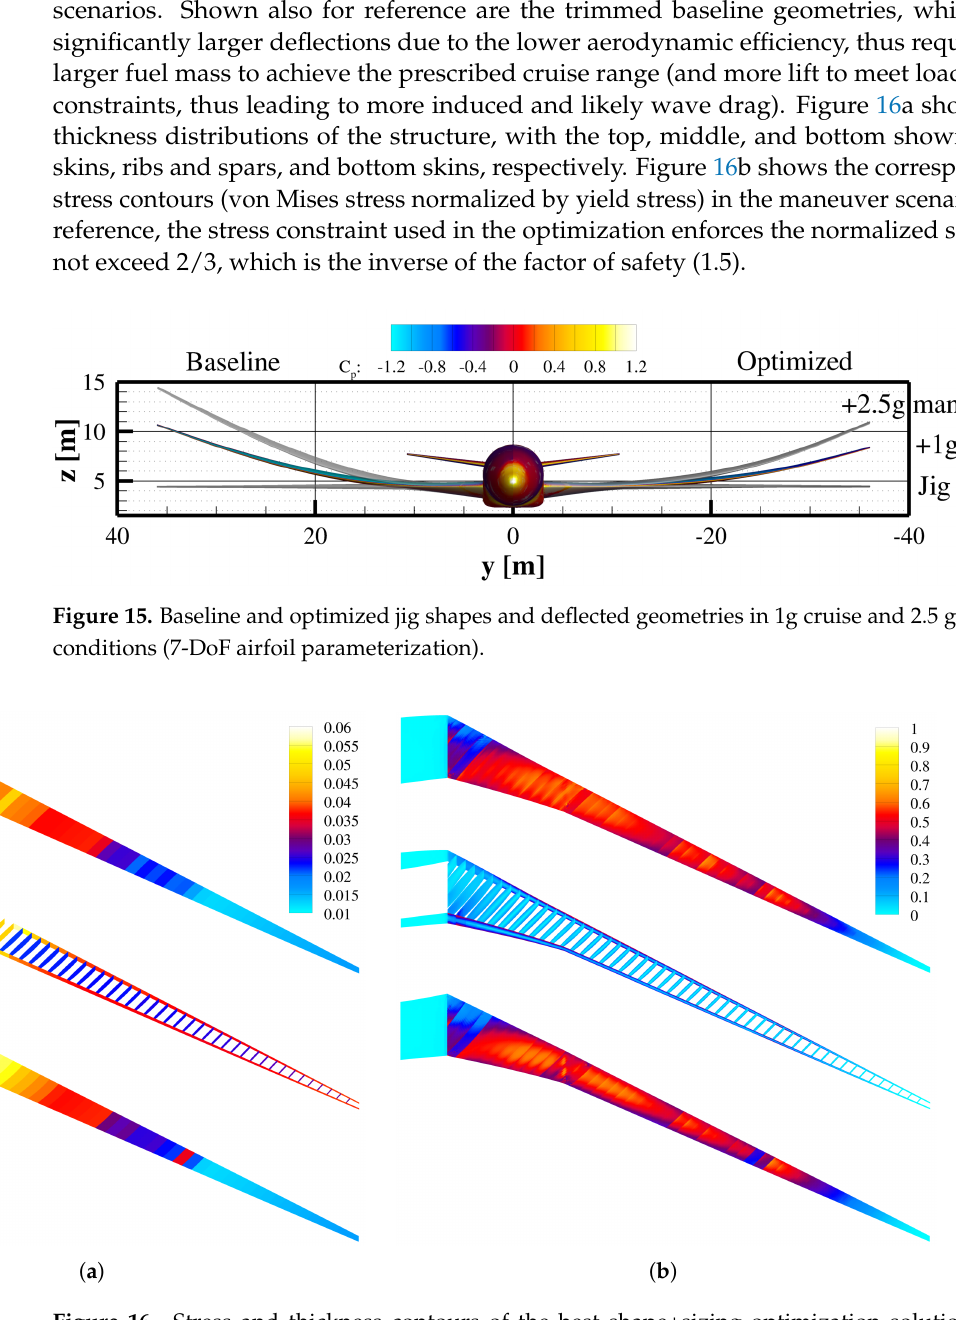
Figure 16. Stress and thickness contours of the best shape+sizing optimization solution (P3a). ( a ) Structural thicknesses; ( b ) von Mises over yield stress for a +2.5 g